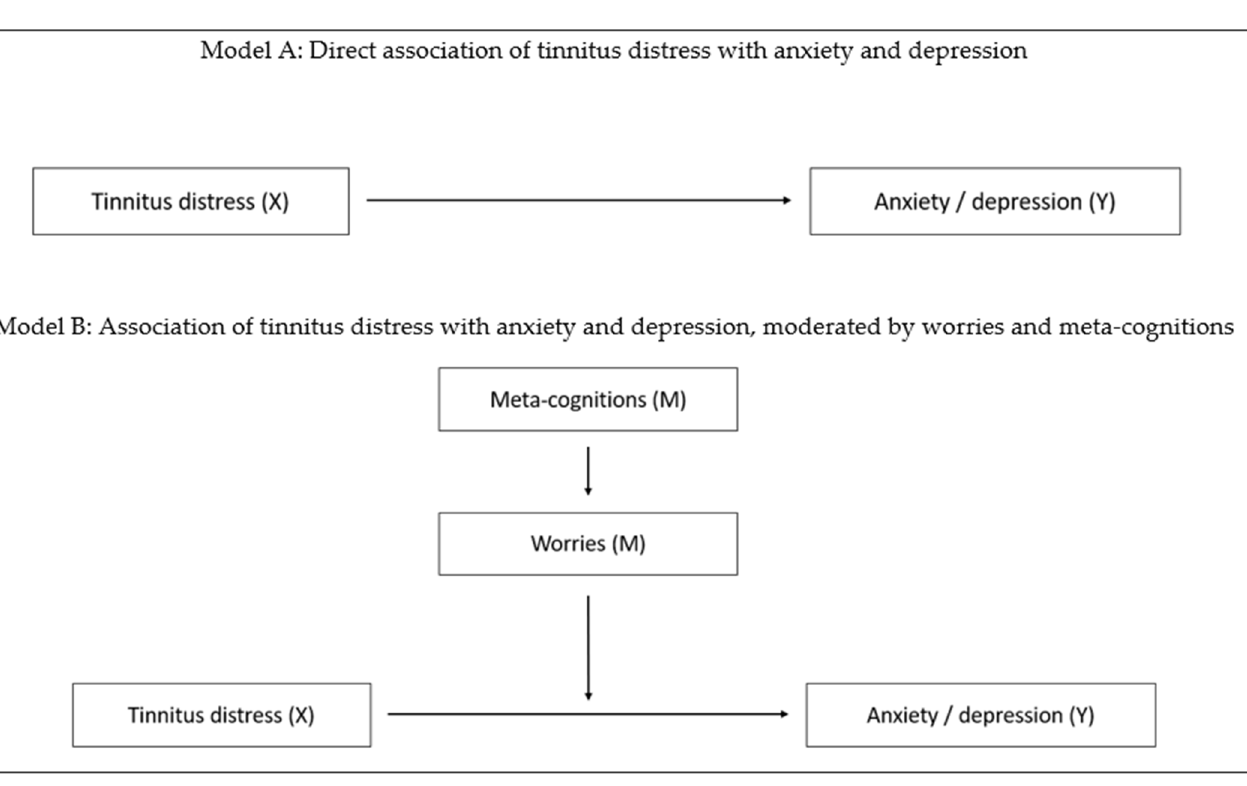
Figure 1. Structural equation models to test the moderating effect of worries and meta-cognitions on the relationship of tinnitus distress with anxiety and depression. Model A depicts the direct association of tinnitus distress with the dependent variables (anxiety, depression). Model B depicts the model with worries as a moderator of the association of tinnitus distress with the dependent variables (anxiety, depression) and meta-cognitions as predictors for worries.